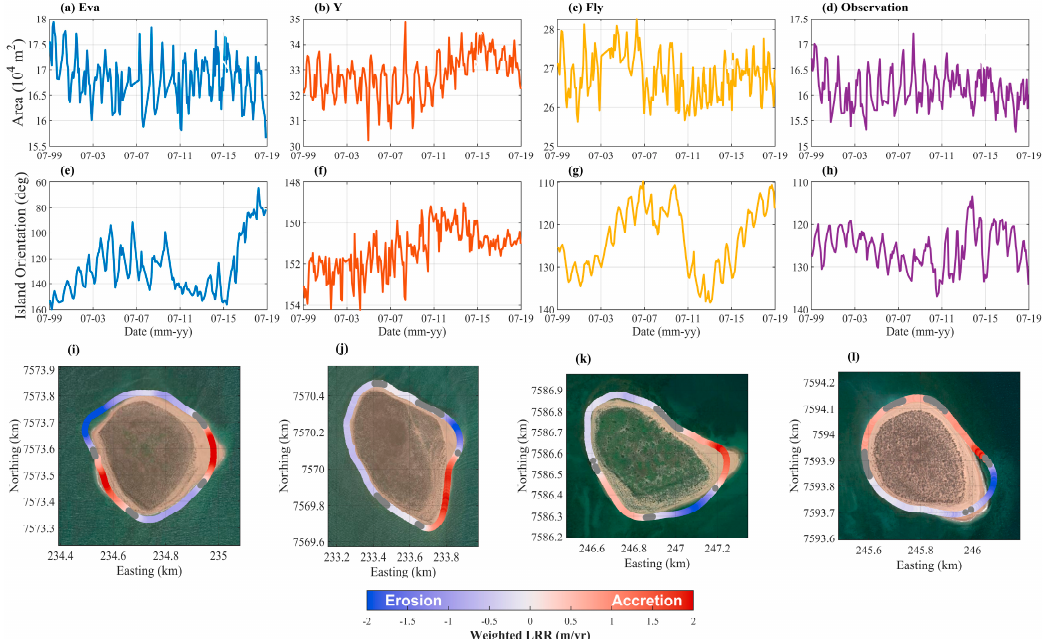
Figure 5. ( a – d ) Temporal variability of reef island area (monthly averaged); note di ff erent y -axis limits. ( e – h ) Temporal variability or major axis orientation (monthly averaged); note di ff erent y -axis limits. ( i – l ) Weighted linear regression rate (LRR) of change from 1999–2019 at each alongshore transect. Blue denotes an erosive trend, red denotes an accreting trend, and grey denotes no significant trend (assessed at a 95% confidence